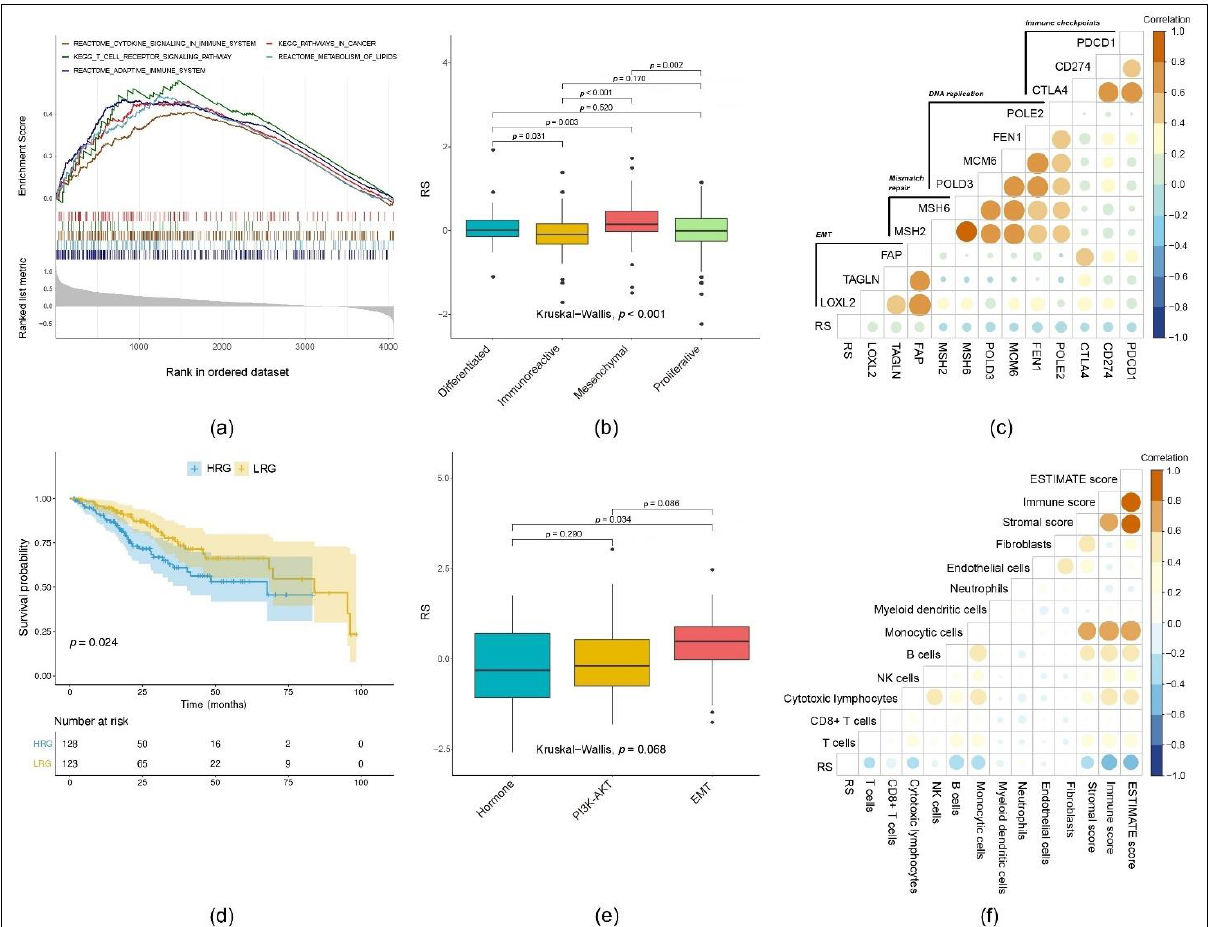
Figure 6. Functional analysis and pan-cancer verification of the model: ( a ) The main pathway groups overexpressed in the HRG. ( b ) RS comparison of the four molecular subtypes of TCGA OC. ( c ) Correlation between RS of OC samples and the expression of representative genes for generic pathway targets in gynecological oncology (Pearson method). ( d ) OS of the HRG and the LRG in the KM curve when applying the 11-gene signature on the cervical squamous cell carcinoma (CESC) cohort. ( e ) RS comparison of the three molecular subtypes of TCGA CESC. ( f ) Correlation between RS of CESC samples and immune scores (Pearson method).